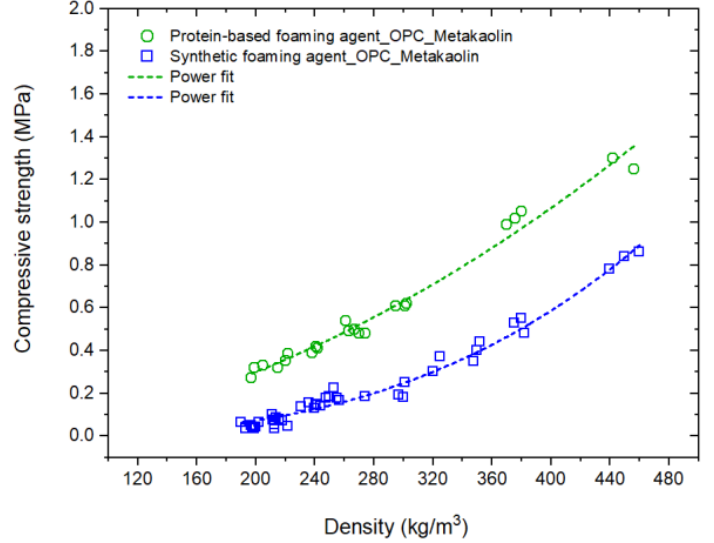
Figure 12. Compressive strength of foam concrete made of OPC with synthetic or protein-based foaming agent and metakaolin.